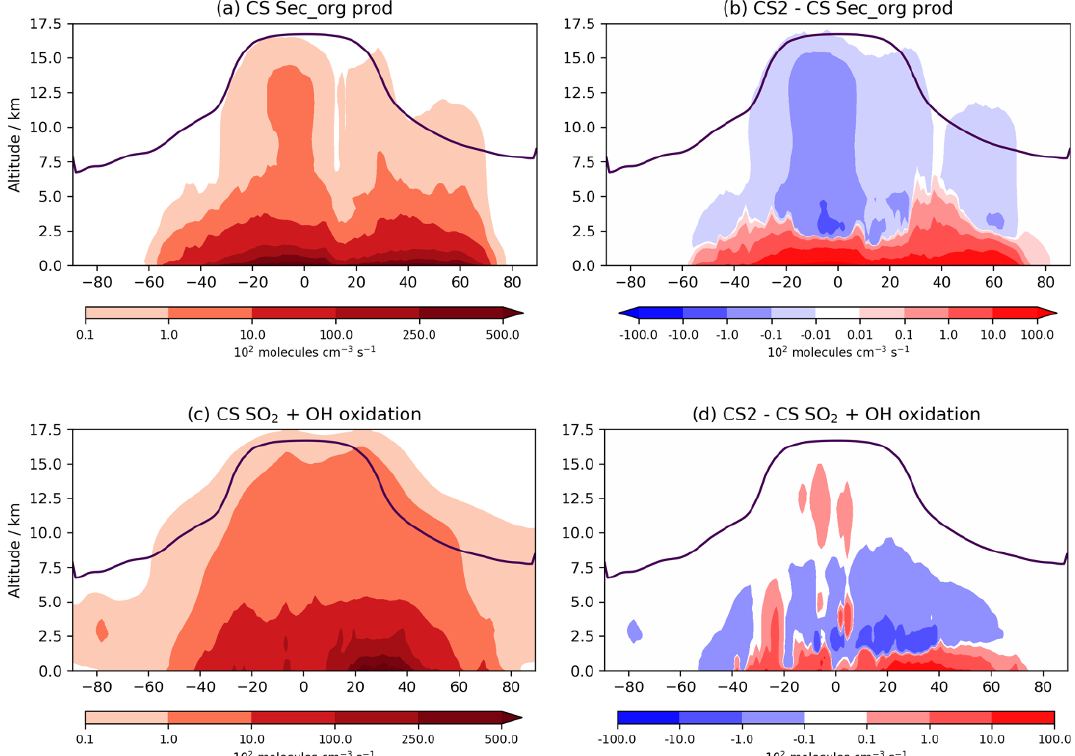
Figure 10. Tropospheric annual zonal mean production flux of Sec_Org in (a) CS and (b) the difference between CS2 and CS. Tropospheric annual zonal mean flux of SO 2 + OH in (c) CS and (d) the difference between CS2 and